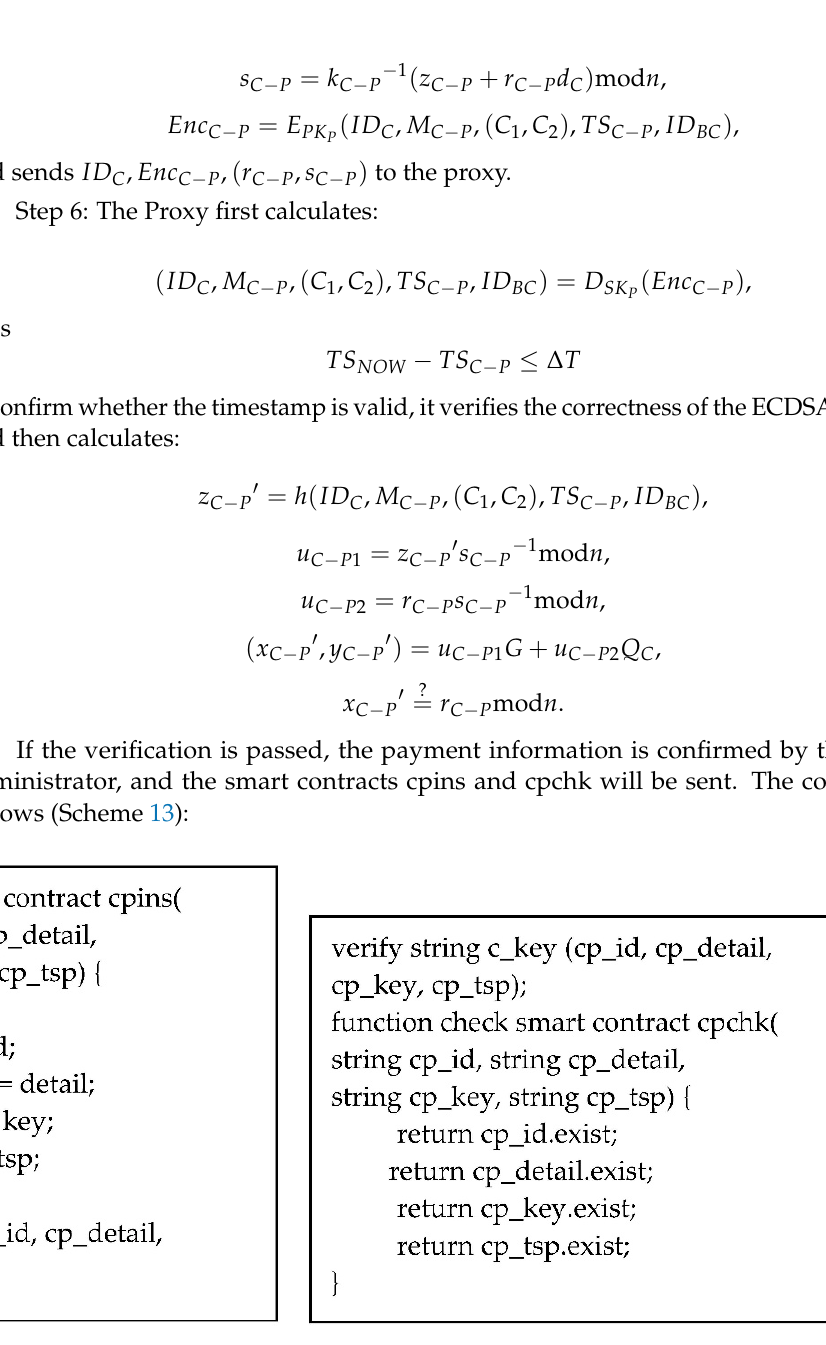
Scheme 13. The smart contracts cpins and cpchk.